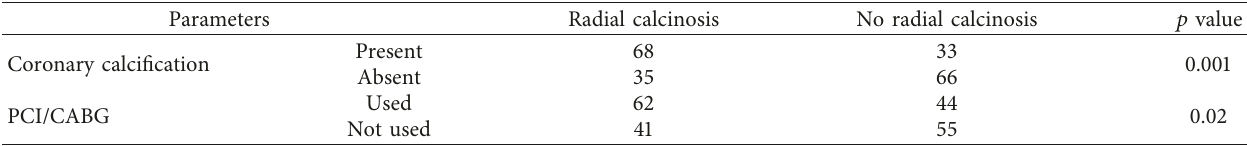
Table 2: Association between the presence of coronary calcification and presence of radial calcinosis (top). Association between the usage of PCI and the presence of radial calcinosis (bottom).